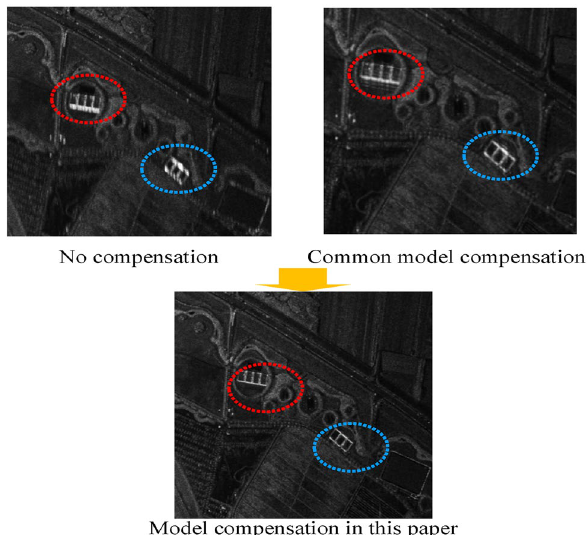
Figure 11. Contrast diagram of radar imaging